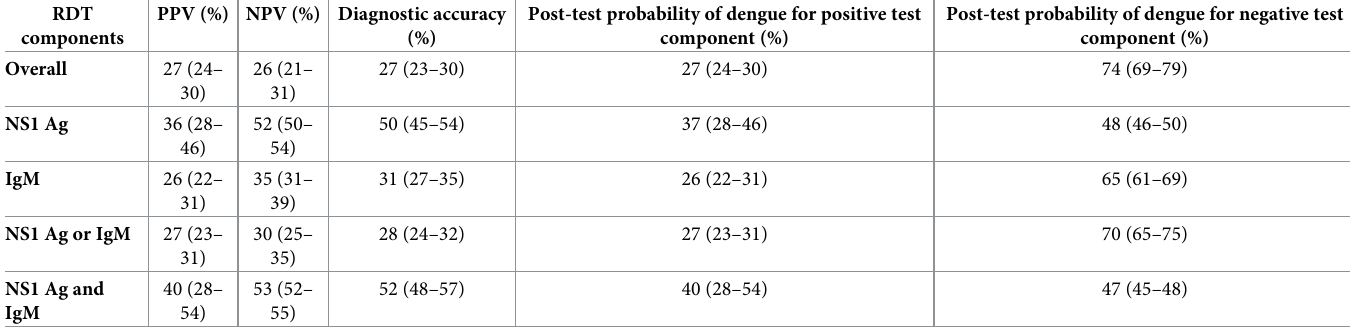
Table 3. Diagnostic utility estimates and their 95% confidence interval for the RDT with a pre-test probability of dengue of 46% (sampling conditions), Reunion, 2019 (N = 671). RDT PPV (%) NPV (%) Diagnostic accuracy Post-test probability of dengue for positive test Post-test probability of dengue for negative test components (%) component (%) component